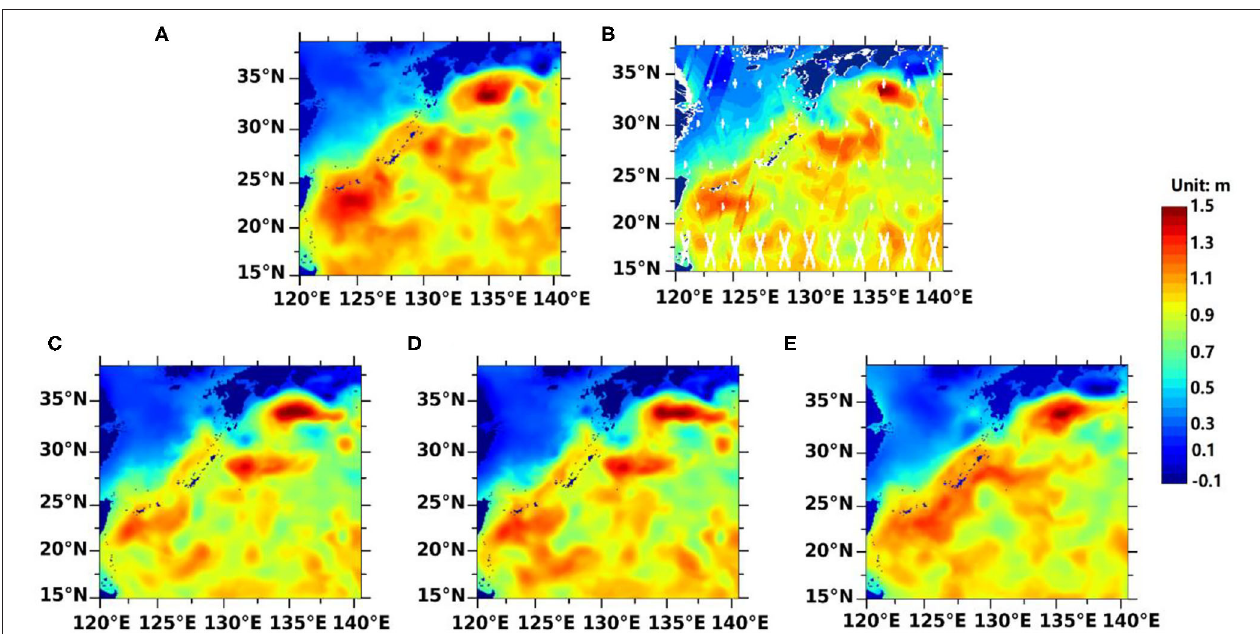
FIGURE 4 | (A) The original SSH field of the regions on HYCOM; (B) the along-track sampled data of OSSEs on HYCOM by the parameters of Guanlan; (C) mapping result of the AnDA method; (D) mapping result of the PredNet; (E) mapping result of the Mapping-PNN method.